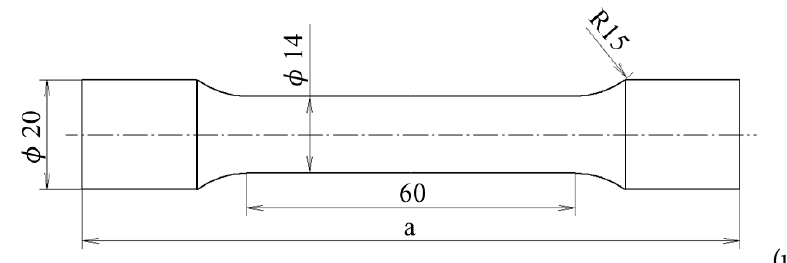
Figure 2. Smooth round bar specimen for uniaxial tensile test (a: 80, 90, or 120).